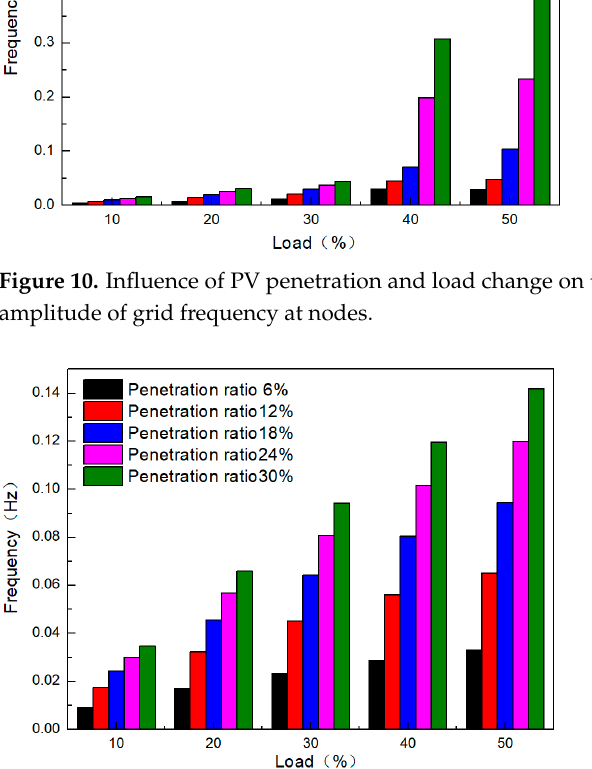
Figure 11. I nfluence of penetration rate and load change on node frequency peak-to-valley ampli- tude difference after photovoltaic storage.